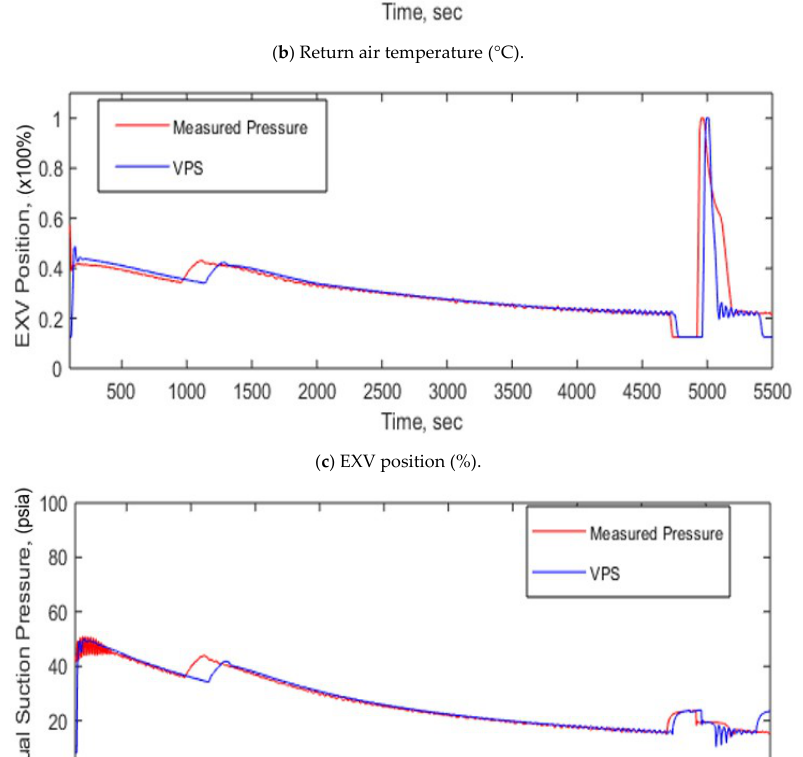
Figure 10. MIL simulation results for scenario 3.